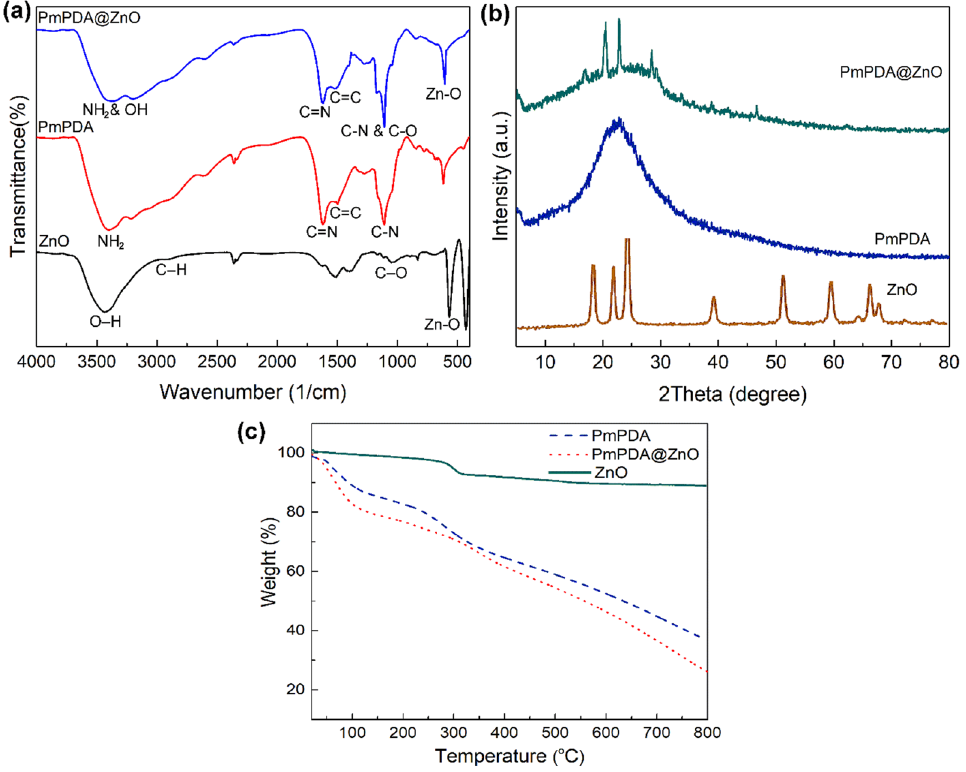
Figure 1. FTIR spectra ( a ), XRD patterns ( b ), and TG curves ( c ) of ZnO NPs, PmPDA, and